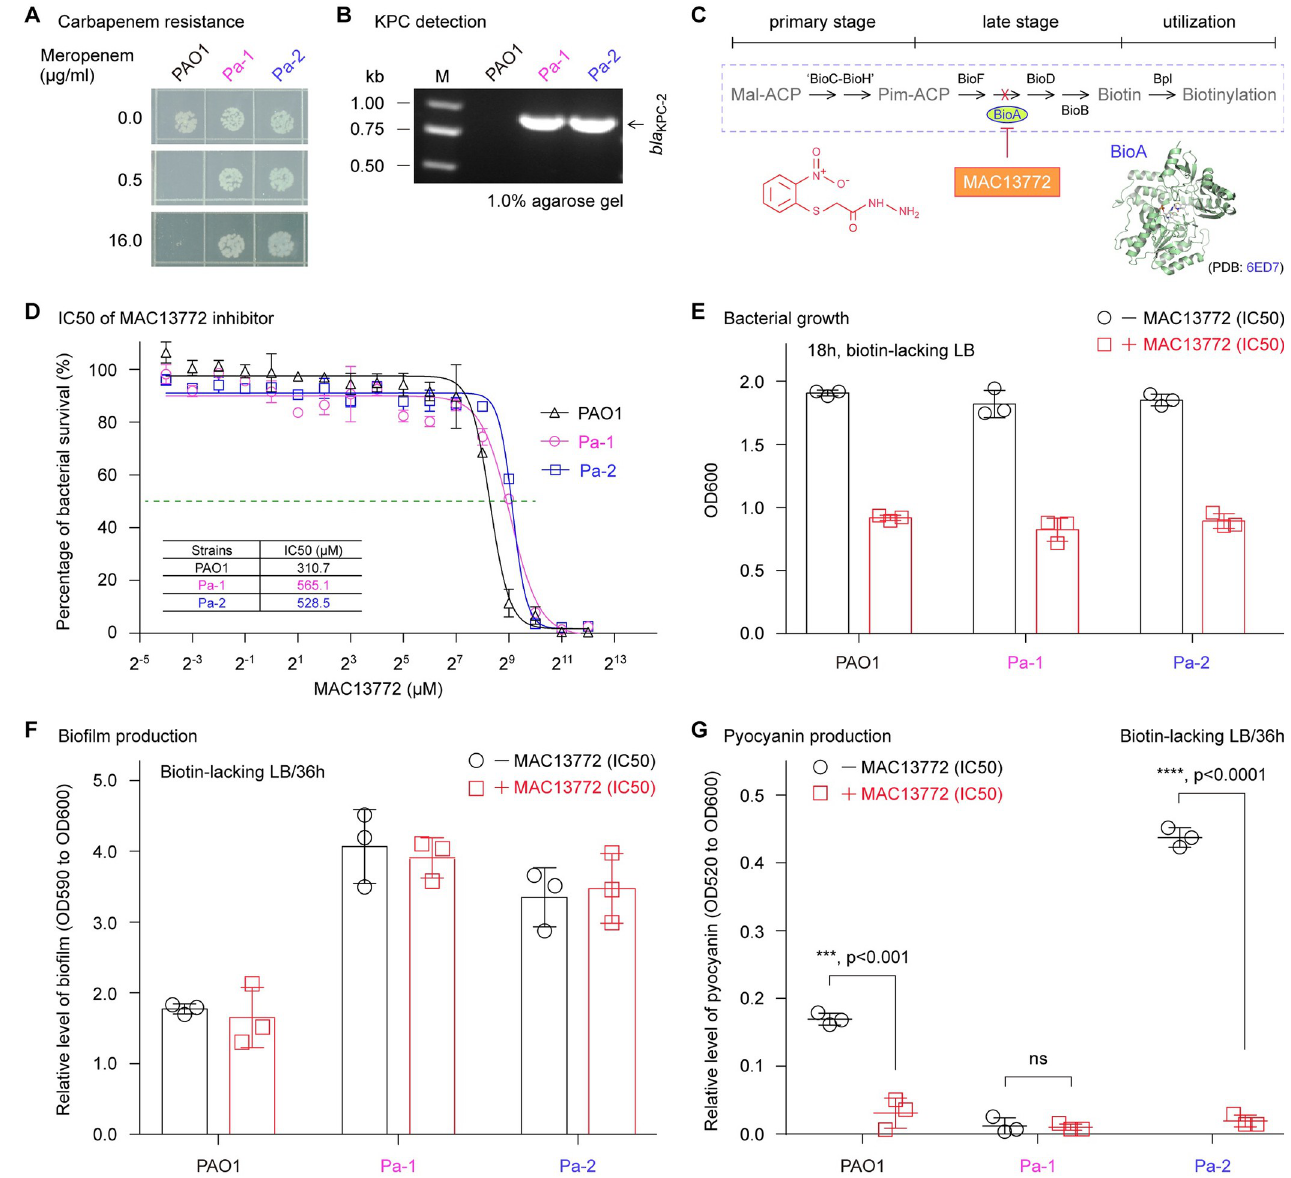
Fig 10. The biotin synthesis inhibitor MAC13772 dampens CRPA viabilities, and selectively interferes the formation of an important virulence factor pyocyanin. Resistance analysis ( A ) and molecular assays ( B ) of two CRPA isolates Pa-1 and Pa-2. Both Pa-1 and Pa-2 harbor bla KPC-2 . Unlike Pa-2 producing the secreted virulence factor pyocyanin, the clinical isolate Pa-1 is a natural mutant defective in pyocyanin synthesis. C. Scheme for MAC13772 known as an inhibitor of BioA, an important enzyme responsible for late stage of Pseudomonas biotin synthesis. In addition to crystal structure of BioA (PDB: 6ED7), chemical structure of BioA inhibitor, MAC13772 was given [15]. D. Measurement for IC50 of MAC13772 in the viabilities of two CRPA isolates and PAO1 virulent strain. E. 18h-growth biomass of three P . aeruginosa in the biotin-lacking LB stressed with IC50 of MAC13772. F. No effect on the virulence